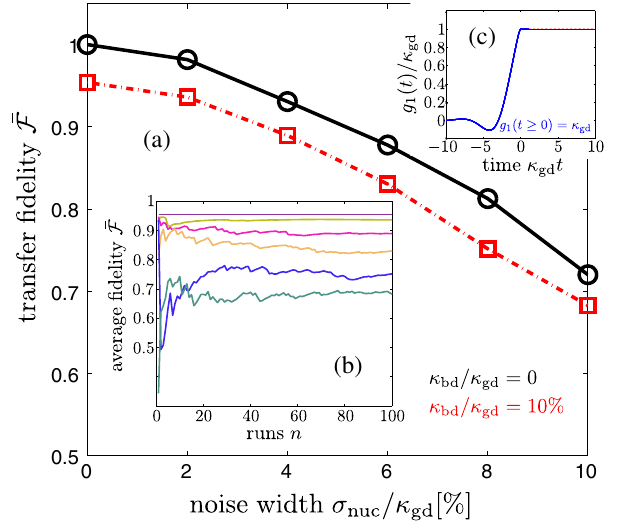
¯ F FIG. 4. (a) Average fidelity of the state transfer protocol for a ffiffiffi p 2 coherent superposition j ψ i ¼ ðj 0 i − j 1 iÞ = in the presence of quasistatic (non-Markovian) Overhauser noise, as a function of the root-mean-square fluctuations σ in the detuning parameters nuc δ 0 (solid line, circles) and κ i ¼ 1 ; 2 Þ , for κ = κ = κ i ð bd gd ¼ bd gd ¼ 10% (dash-dotted line, squares). (b) After n ¼ 100 runs with ¯ F random values for δ , approximately reaches convergence. The i 0 ; 2 ; … ; 10 Þ % (from top to bottom) = κ curves refer to σ nuc gd ¼ ð 10% . (c) Pulse shape g = κ for κ 1 ð t Þ for first bd gd ¼